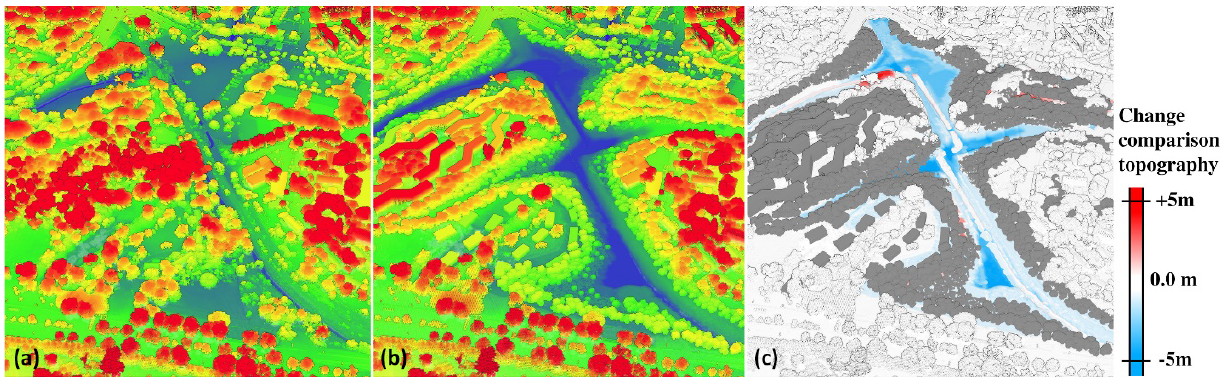
Figure 4. Change detection between laser-scanned and modified point cloud models. A point cloud model from aerial laser- scanned data, colored by height 3–40 m AMSL, shows a 3 m-wide canal (in dark blue) aligned to the former railway (a). The point cloud model is manipulated to improve the capacity of water catchment, shown with the same height gradient (b). The design maintains the original depth of the canal and height of the railway, both colored in white in the topographic change comparison (c). The comparison shows how existing features can be retained locally during the design process, while changes occur in less-significant